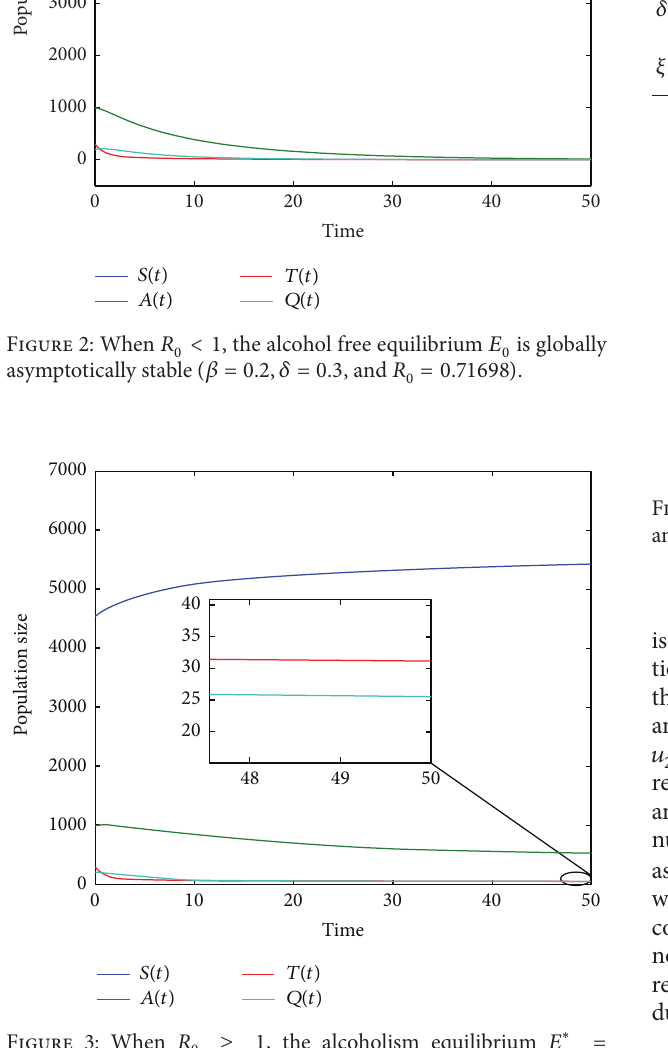
the values of optimal controls obtained lastly. The iterations continue until convergence takes place.